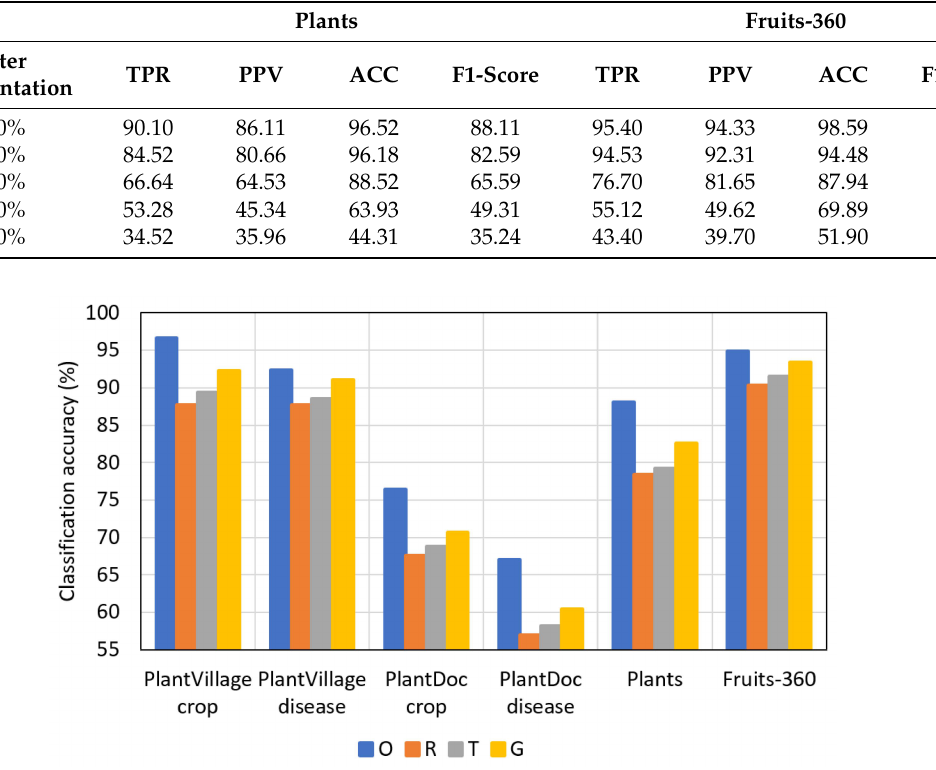
Figure 11. Comparison of F1-scores based on all the datasets (original dataset (O), reduced dataset (R), dataset augmented by conventional method (T), and dataset augmented by PI-GAN (G)). The datasets have been reduced to